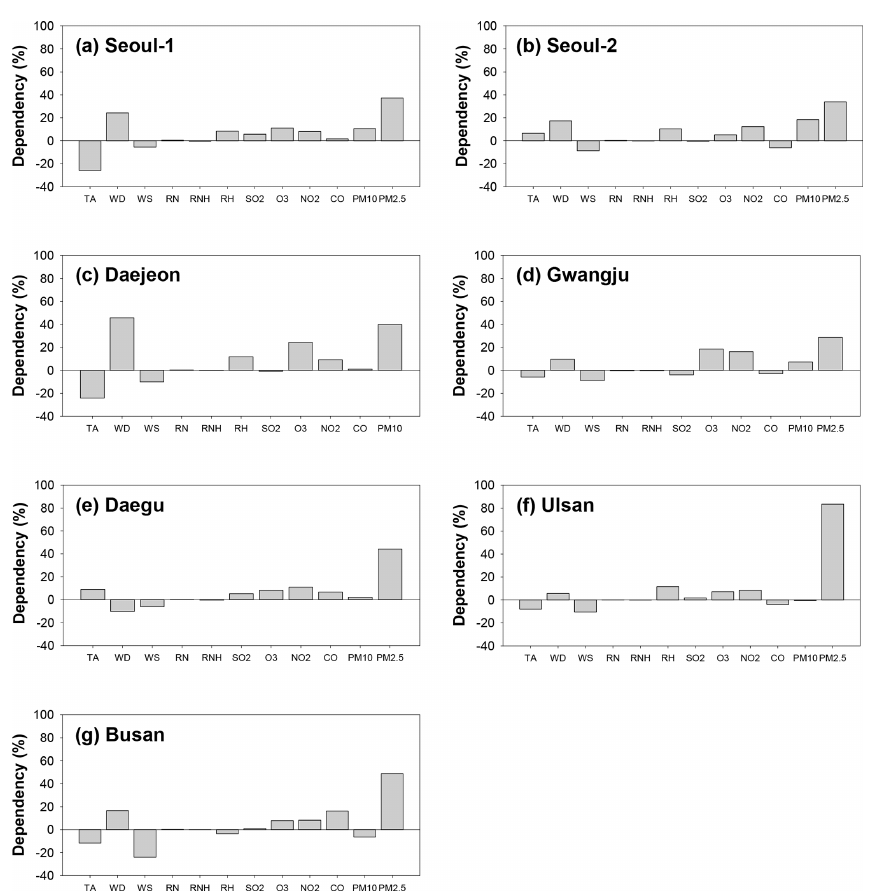
Figure 10. Same as Fig. 9 but for PM 2 . 5